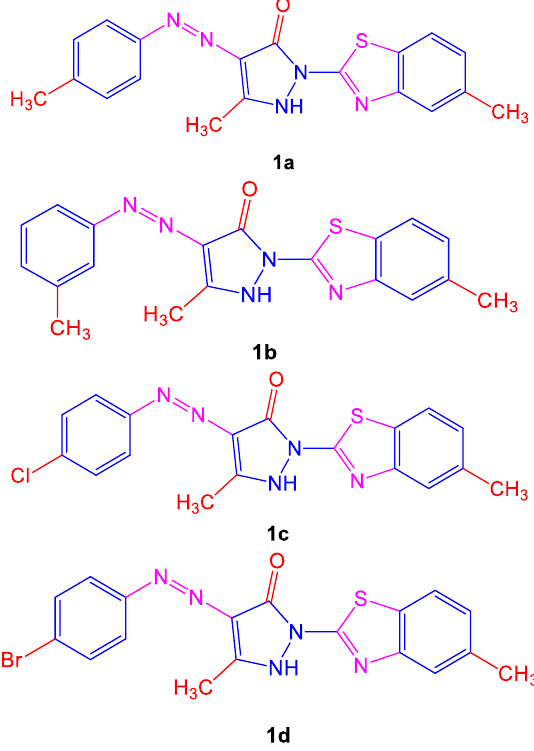
Figure 1. Structures of azo dye compounds ( 1a – d ) showing anti-mycobacterial activity.